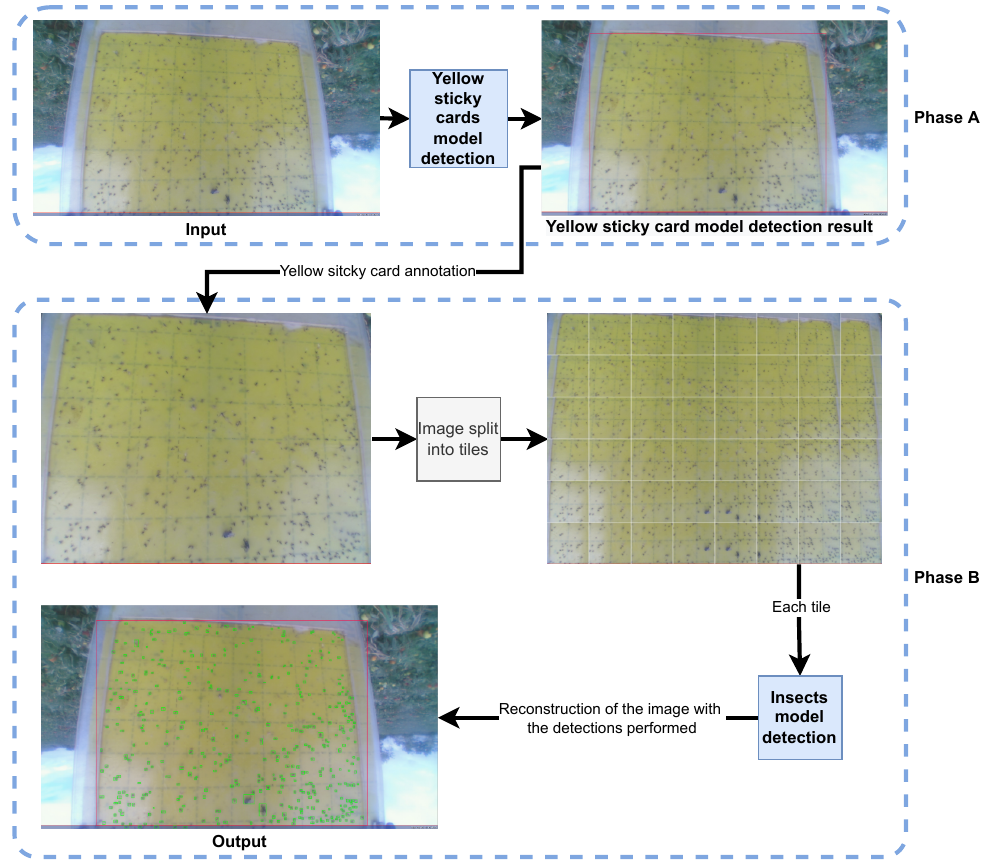
Figure 2. Pipeline for insect detection.